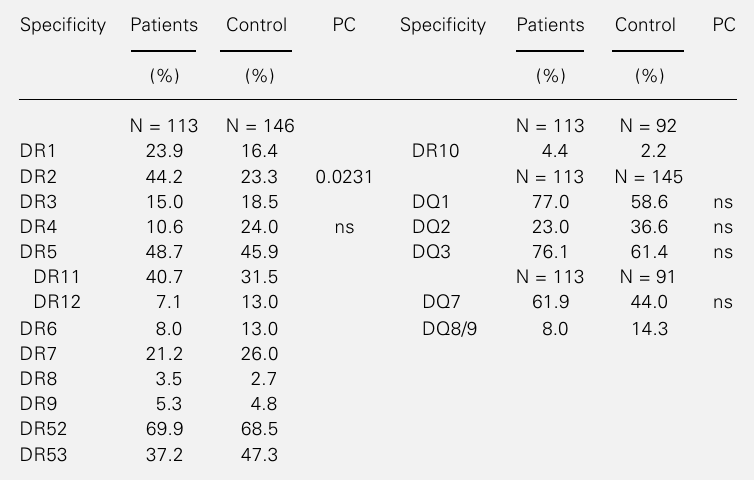
Table 1 - HLA-DR and DQ antigen frequencies in the total sample of patients with leprosy and in the control group. ns = Nonsignificant (indicated only if P<0.05 before correction); P = probability; PC = corrected probability (Chi-square test). Specificity